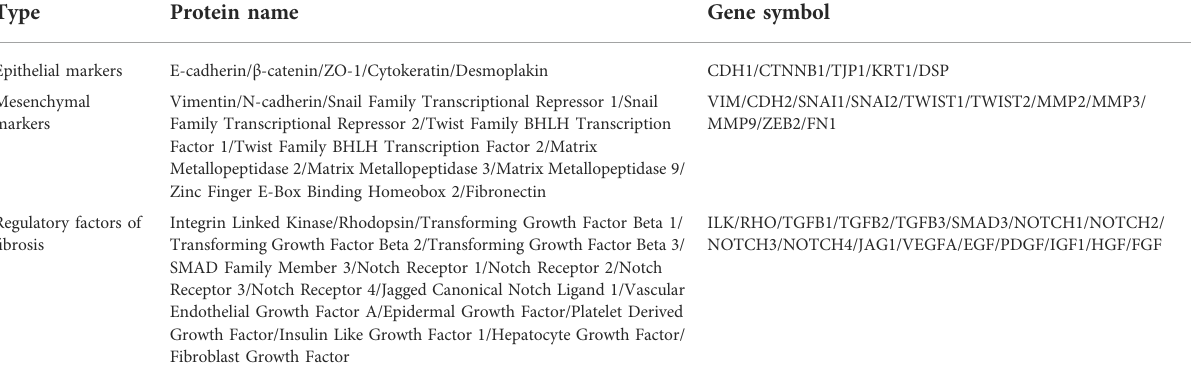
TABLE 1 The EMT-related gene set consisted of epithelial markers, mesenchymal markers and regulatory factors of fi